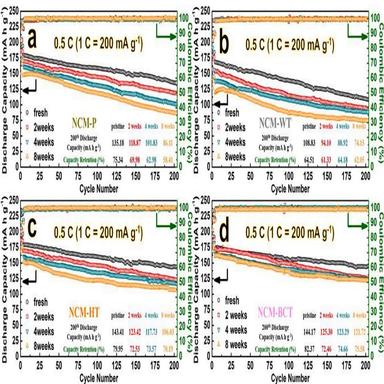
Cyclic performance comparison of NCM811 cathodes materials with various treatments before/after air exposure for different periods: (a) NCM-P, (b) NCM-WT, (c) NCM-HT and (d) NCM-BCT, respectively.